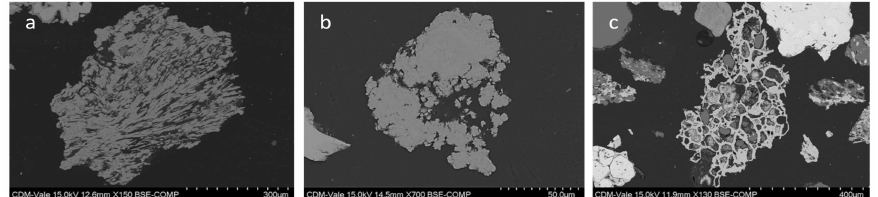
Figure 6. Backscattered electron images of the SEM, showing microtextures of goethite from the studied amphibolitic itabirite: ( a ) fibrous amphibolitic, ( b ) massive and ( c )